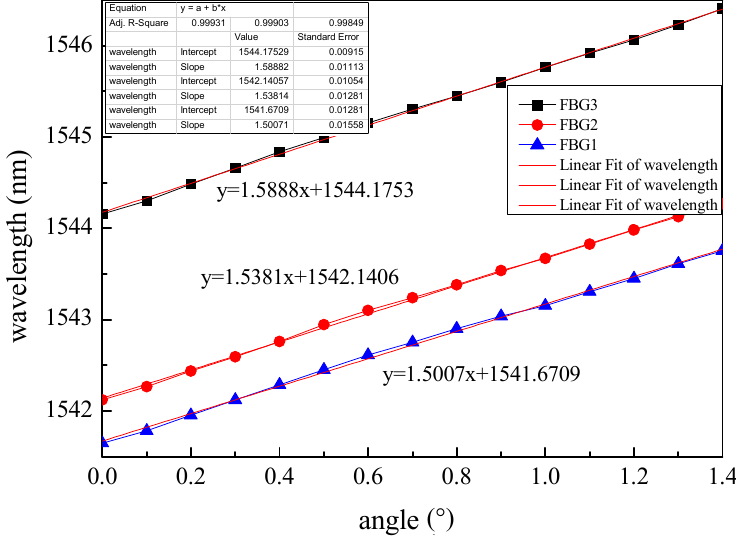
Figure 6. The test result of the FBG strain sensor.